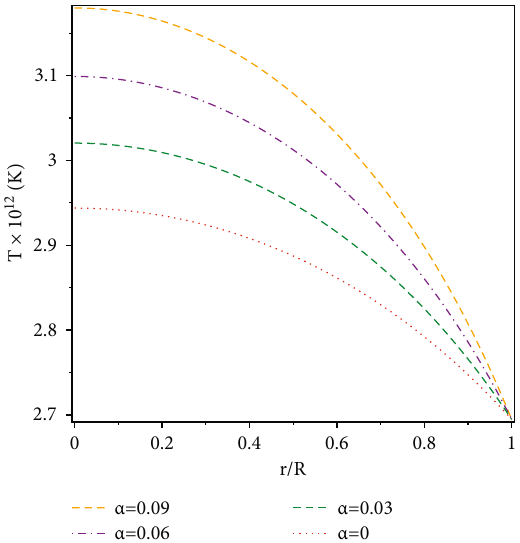
Figure 1: Variation of anisotropy ð Δ Þ with the radial coordinate for di ff erent values of α for the strange star SMCX-4, where B MeV/(fm) 3 , R = 9 : 711 km, and M = 1 : 29M ⨀ .